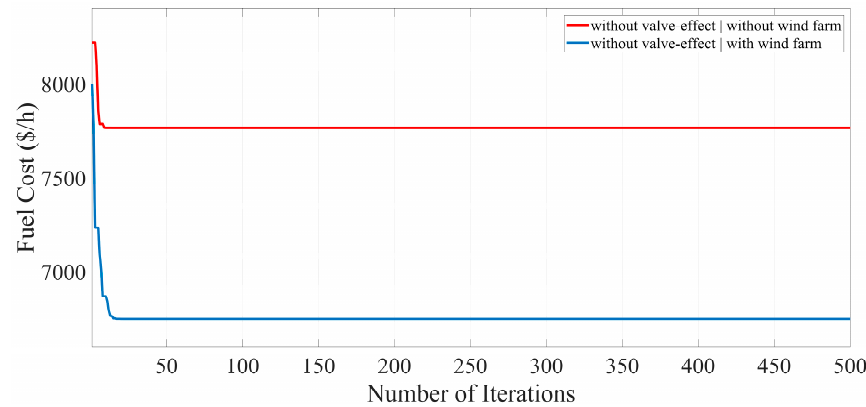
Figure 8. The convergence curves for the fuel cost minimization considering and neglecting the valve-point effect for the Test System 2.